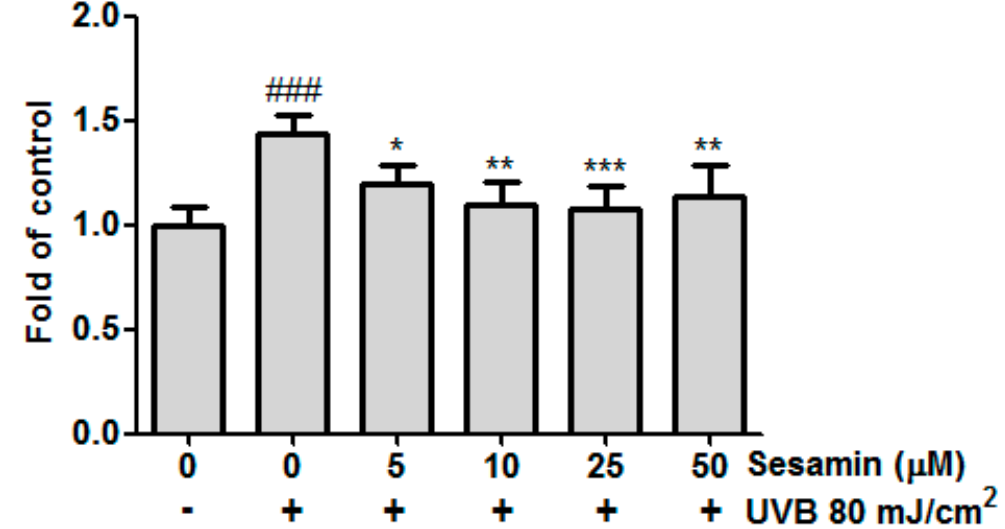
Figure 2. Sesamin inhibited the intracellular oxidative stress in Hs68 cells after ultraviolet (UVB) exposure. ### p < 0.001: Significant difference versus non-irradiation group. * p < 0.05; ** p < 0.01; *** p < 0.001: Significant difference versus non-treatment group.